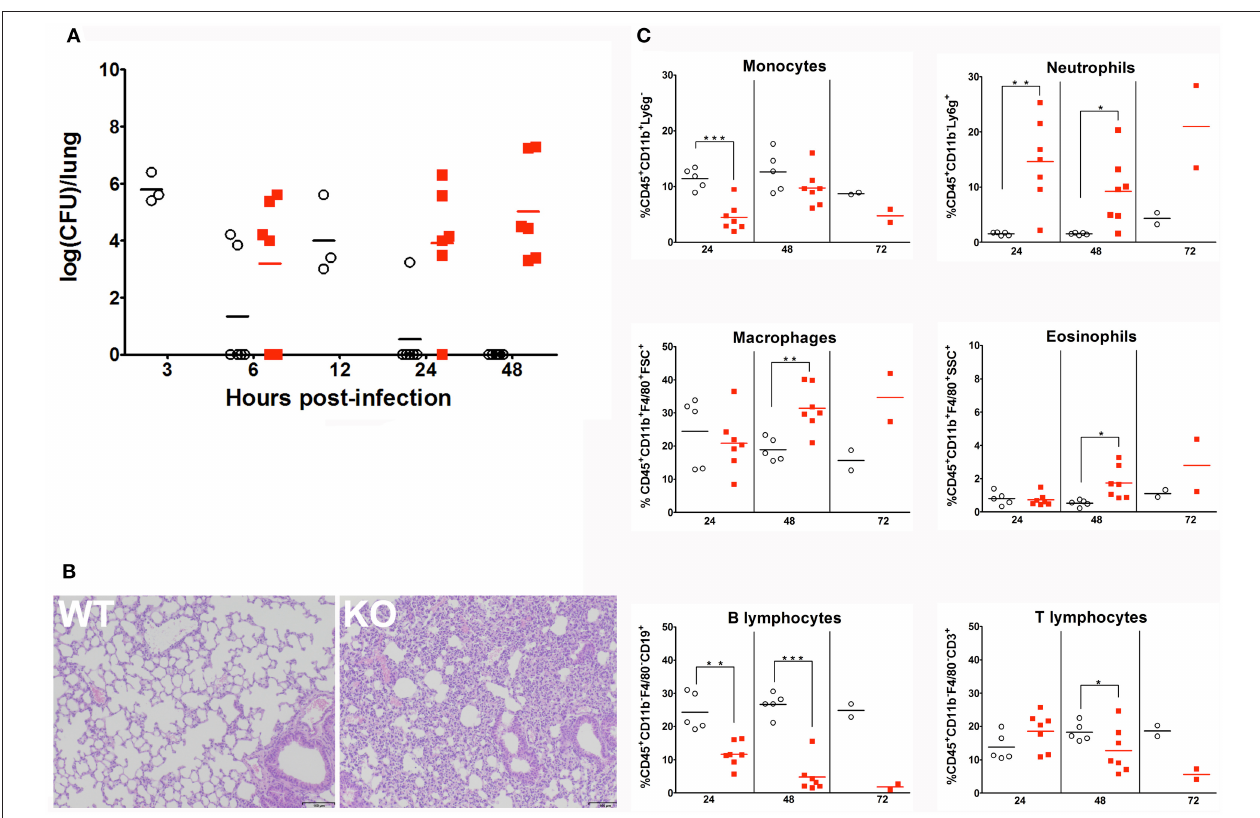
FIGURE 2 | Ghrh − / − mice fail to clear S. pneumoniae infection from lung (A) WT ( ◦ ) and KO mice ( ) were inoculated by S. pneumoniae via i.n.. At 3, 6, 12, 24, and 48h post-infection, animals were sacrified and lung were sampled to measure colony-forming unit (CFU). All results are presented as individual response and mean. N = 3–6 mice per group. (B) Lung sections of S. pneumoniae -infected WT and KO mice HE-stained. Result shown are representative of two independent experiments. n = 6 mice per group. (C) Percentage of lung leucocytes: monocytes, neutrophils, macrophages, eosinophils, B lymphocytes and T lymphocytes of CD45.2 positive cells recruited to the lung of WT ( ◦ ) and KO ( ) mice 24, 48 and 72h post-infection. All results are presented as individual and mean response. N = 2–7 mice per group. * p < 0.05; ** p < 0.001; *** p < 0.0001 (unpaired Student t -test).